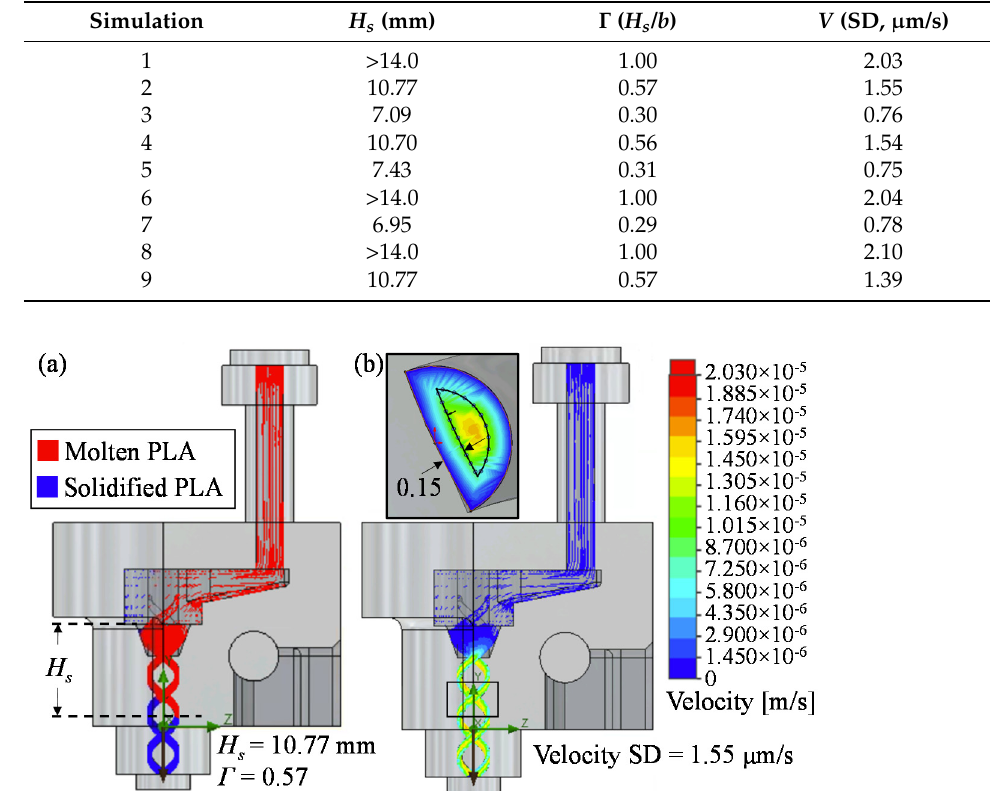
Table 2. Simulation results.